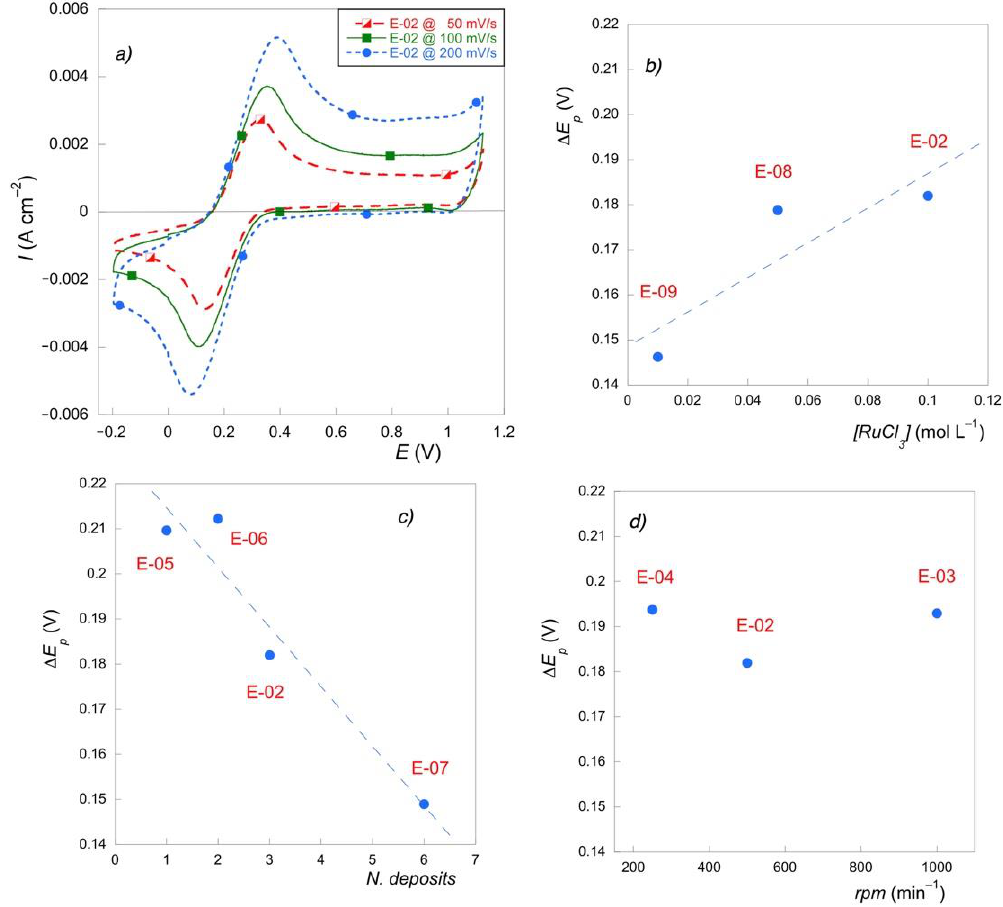
Figure 4. ( a ) Cyclic voltammetry for E-02 at different rates in presence of Fe(CN) 63 − /4 − couple; ( b ) ∆ E p (V) vs. precursor concentration; ( c ) ∆ E p (V) vs. number of deposits; ( d ) ∆ E p (V) vs. spin rate. Linear sweep voltammetry was recorded in 0.1 mol · L − 1 Na 2 SO 4 solution in